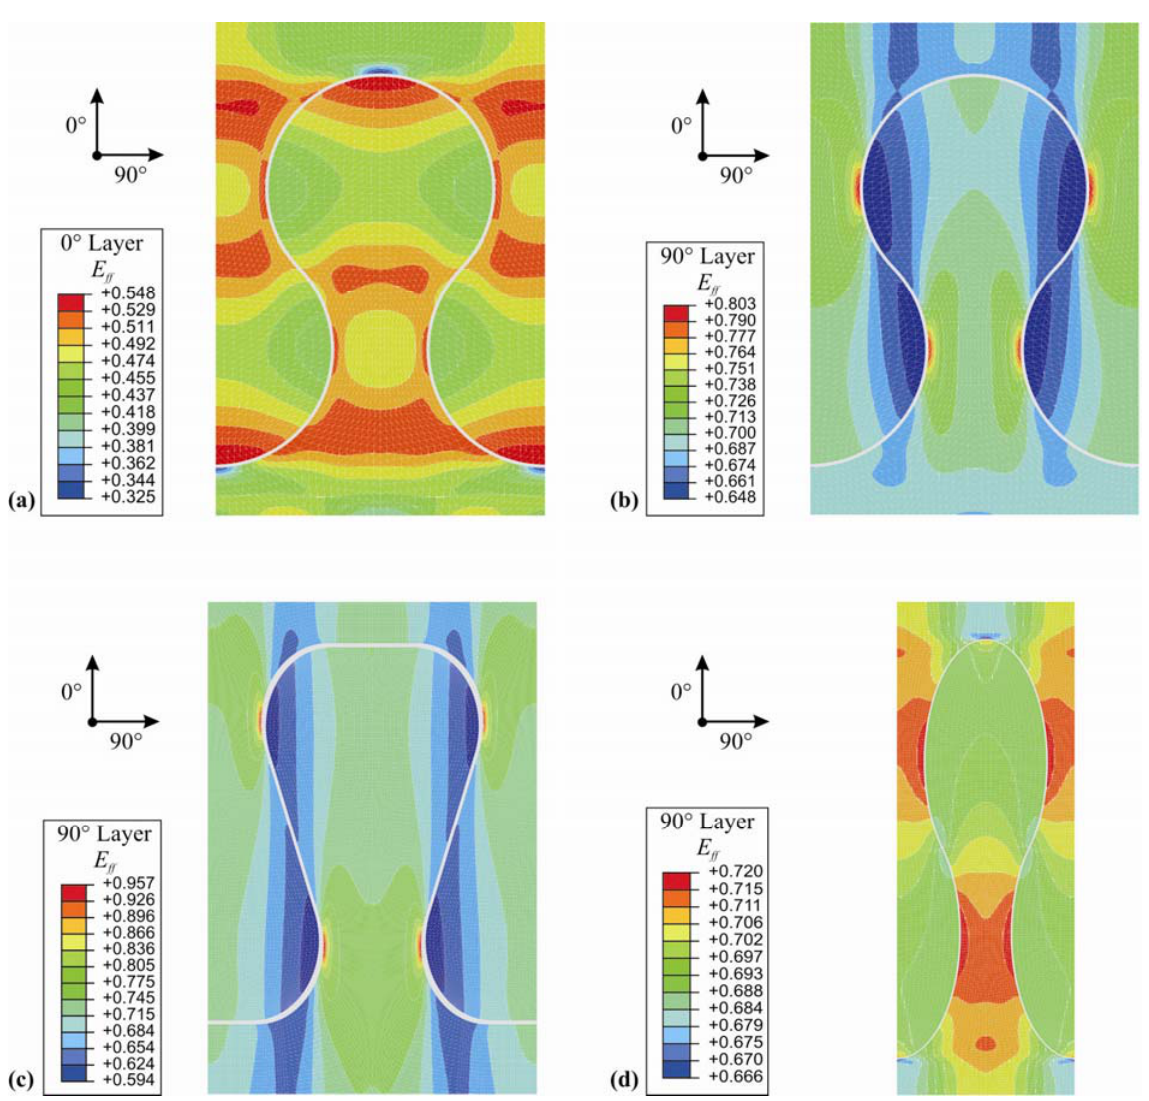
Figure 5. Resultant stress effort for ( a ) circular interlock in 0°-layer; ( b ) circular